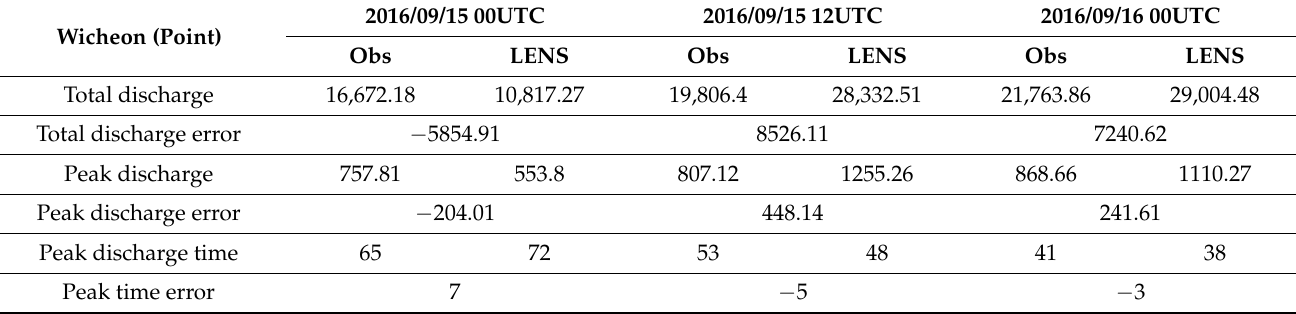
Table 12. LENS point discharge data results from 2016/09/15 00UTC to 2016/09/16 00UTC.